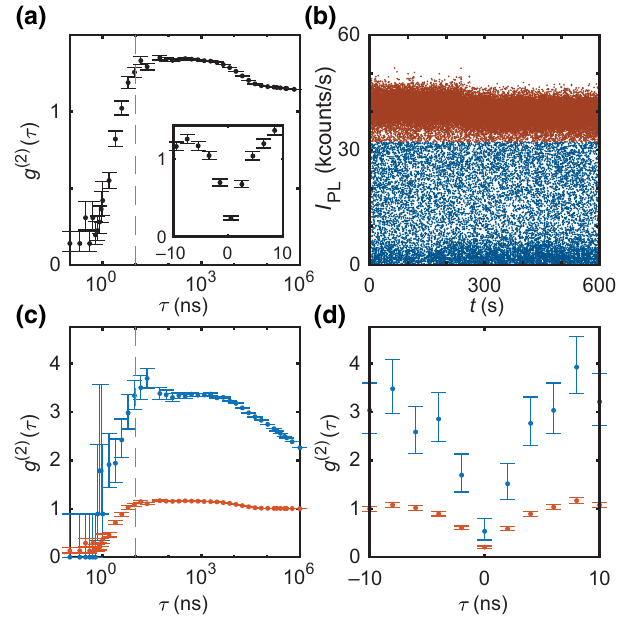
FIG. 7. The output of time-tagged time-resolved data pro- cessed for photon correlations, shown for an example case of an emitter in h -BN with blinking. (a) The raw photon-emission- statistics data from an emitter in h -BN processed with logarith- mic bins. The inset shows the same data processed on a linear scale. The dashed line denotes τ = 10 ns. (b) The intensity versus time data binned at 0.01 s, displaying partitioning at 32 kcounts/s between an on (orange) blinking state and an off (blue)